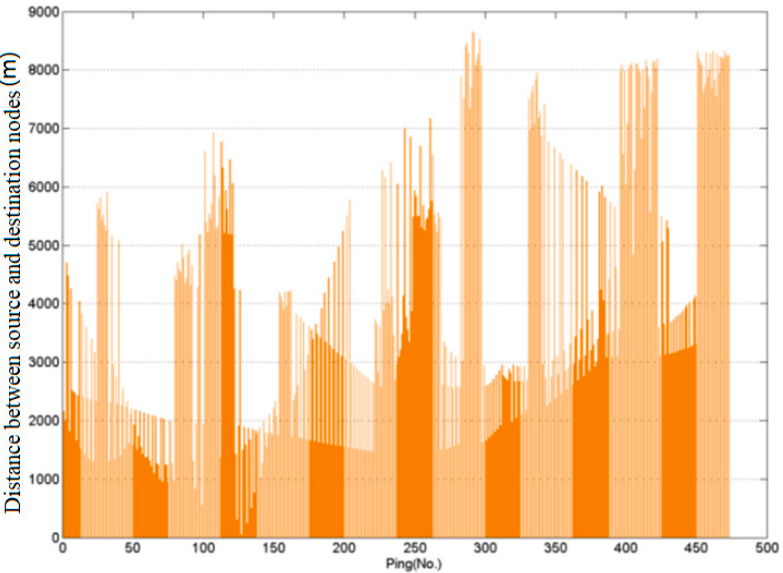
Figure 13. Distance between source and destination nodes.